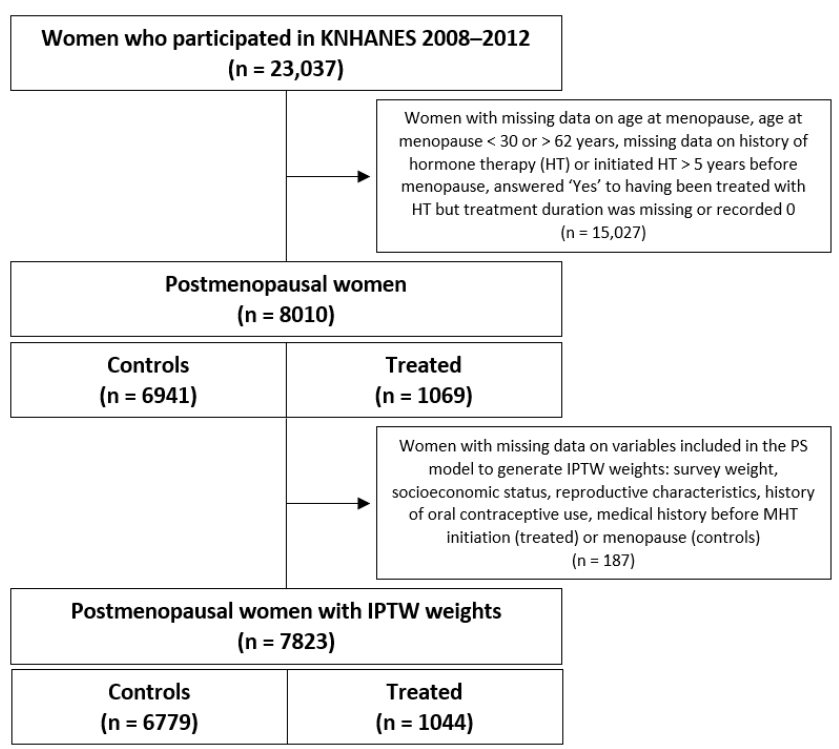
Figure 1. Identification of study population within KNHANES participants (2008–2012).